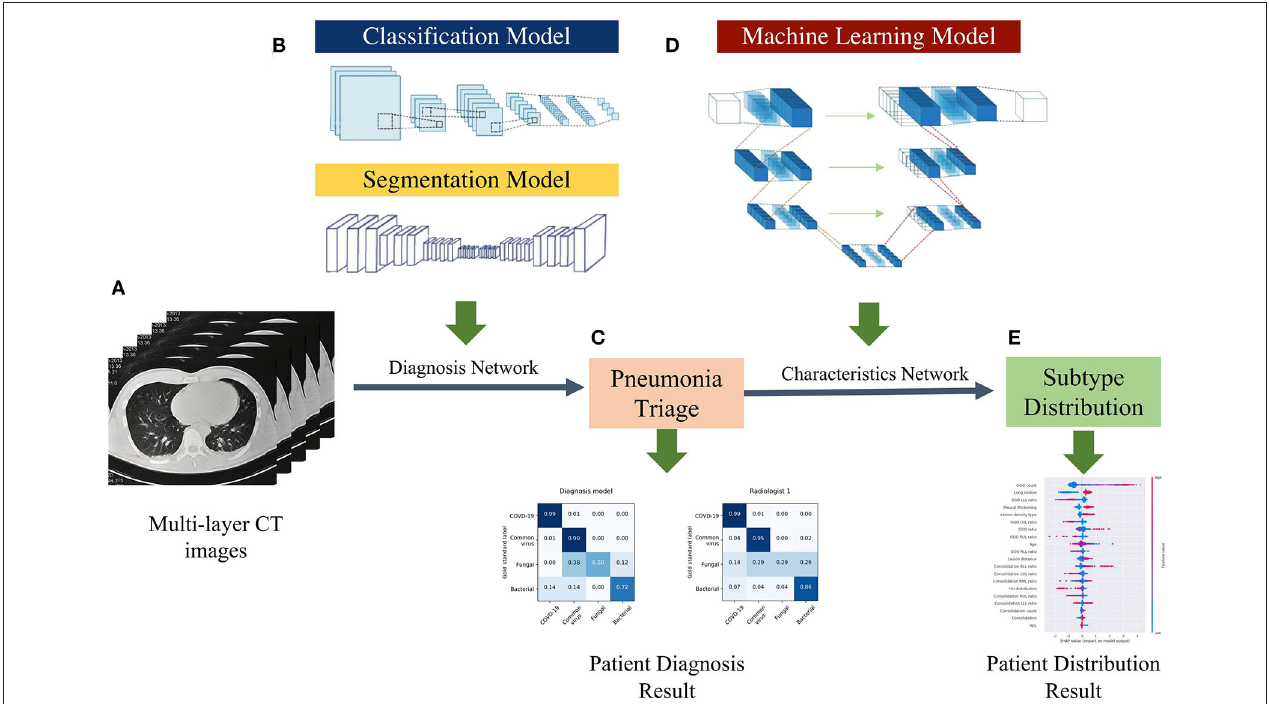
FIGURE 2 | AI framework of the study. (A) Using multi-layer raw pneumonia CT images and associated etiology labels as input, the data will be flipped horizontally as data augmentation to increase the number of training samples and reduce the possibility of over-fitting. (B) The proposed DL system is composed of two models: a classification model and a segmentation model. The classifier can detect abnormal slices and predict pathogen type scores, while the segmentation model extracts CT image features (lung lobe and the contour of the lesions). (C) The voting schema calculates the ratio of particular positive slices and votes on their patient-wise triage base on the image-wise diagnosis score. (D) The ML system is trained with the clinical factors and CT features quantified by the DL system. (E) Patients CT factors and clinical features distribution and probabilities evaluated by characteristics network to assist radiologists in understanding the predicted results produced by the